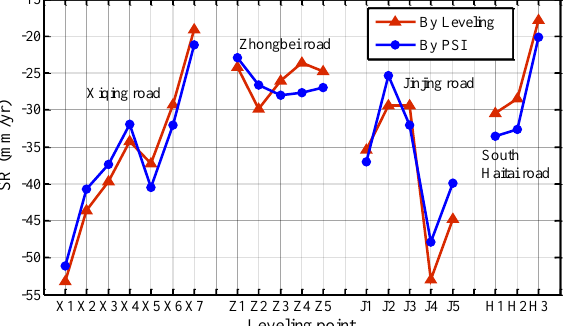
Fig. 6 Comparison between subsidence results derived